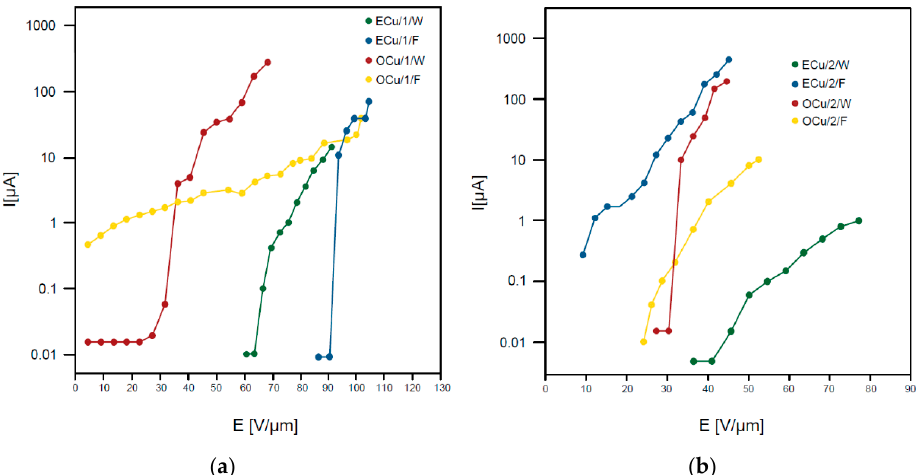
Figure 10. Emission current vs. voltage between anode and cathode for the single-layered ( a ) and double-layered ( b ) samples.